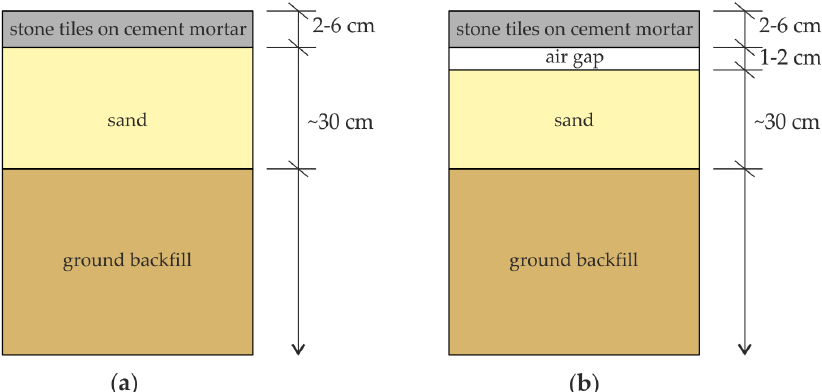
Figure 3. Schematic sketch of floor layers in the trial pit: ( a ) appropriate cross ‐ section (without air gap); ( b ) cross ‐ section with damage (air